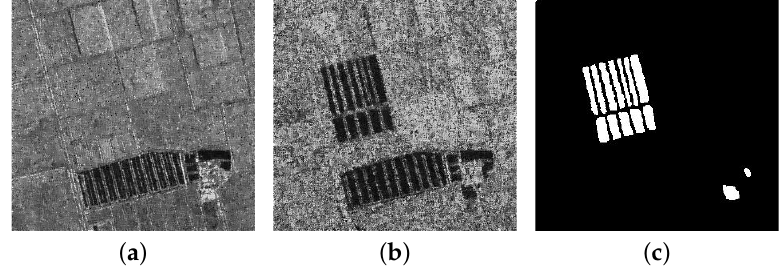
Figure 5. Farmland dataset. ( a ) SAR image acquired in 2008. ( b ) Optical image acquired in 2009. ( c ) Reference image.